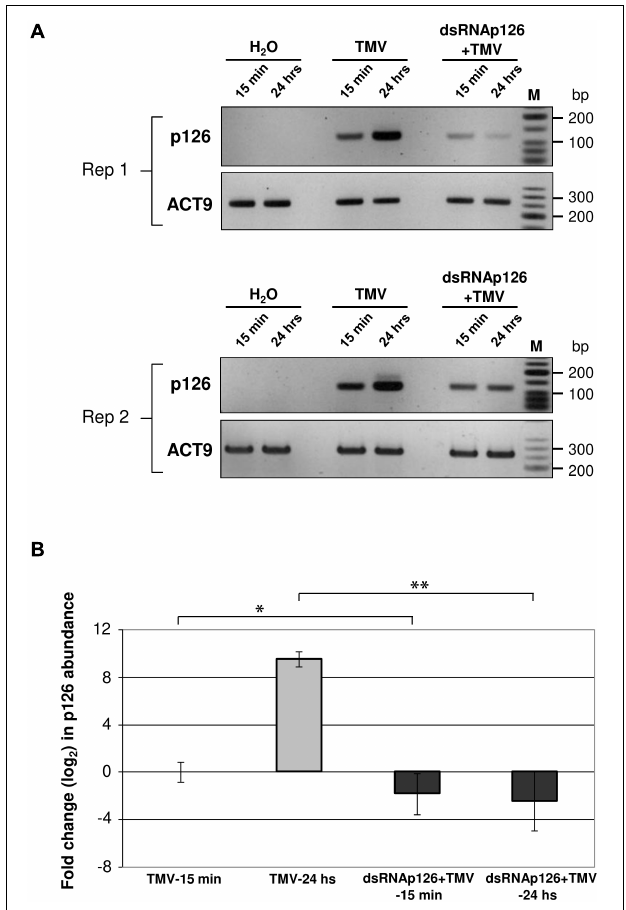
FIGURE 6 | Analysis of TMV p126 expression levels in TMV and dsRNAp126 + TMV treatments by RT-PCR. (A) Gel images from two biological replicates (Rep 1 and Rep 2) showing p126 RNA abundance by semiquantitative RT-PCR. RNA samples were collected at two time points (15 min and 24 h post treatment). Primers for the detection of p126 were designed outside the region (namely 426–1,091 of the TMV genome) that was used for the production of dsRNAp126. Nt-ACT9 was employed as an endogenous reference gene. H 2 O indicates samples collected from the negative control treatment. M is a low molecular weight DNA marker (New England Biolabs, United States). (B) Relative quantification of p126 expression levels by RT quantitative PCR, employing Nt-ACT9 for normalization purposes. Depicted are the log 2 -transformed values of p126 abundance in TMV (light-gray columns) and dsRNAp126 + TMV (dark-gray columns) treatments. The value of p126 at 15 min in TMV treatment was set as 1 (log 2 value was 0). Bars represent standard errors. Statistical analysis was performed per time point using Student’s t -test. Asterisks indicate significant differences between TMV and dsRNAp126 + TMV treatments at the respective time points (* p < 0.1; ** p <